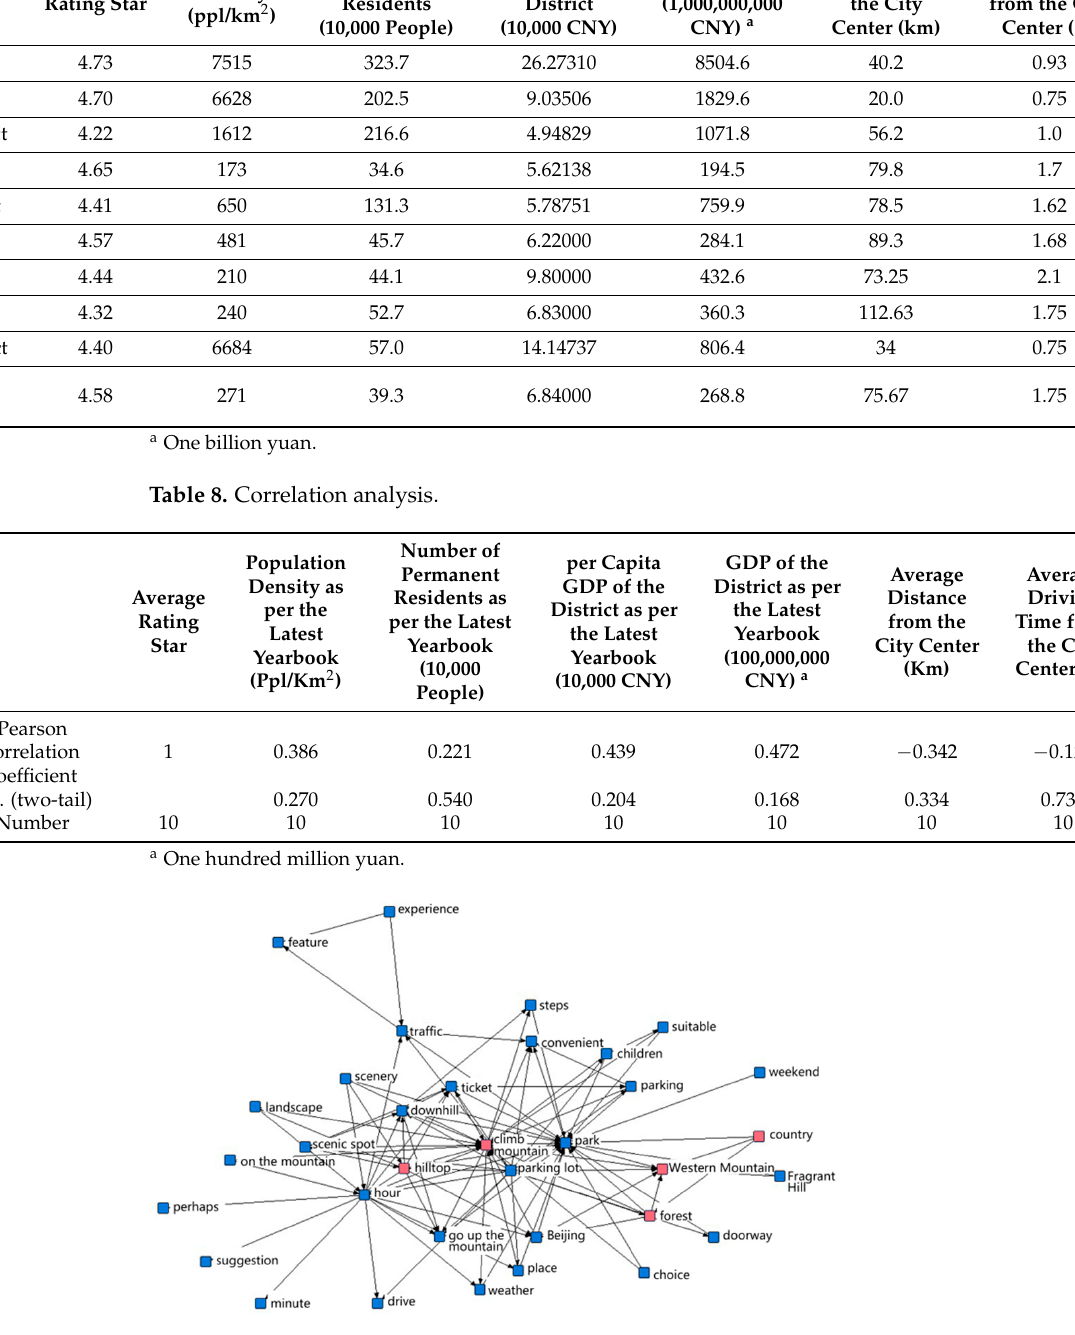
Figure 15. The semantic network for the Taihang Mountain landscape.